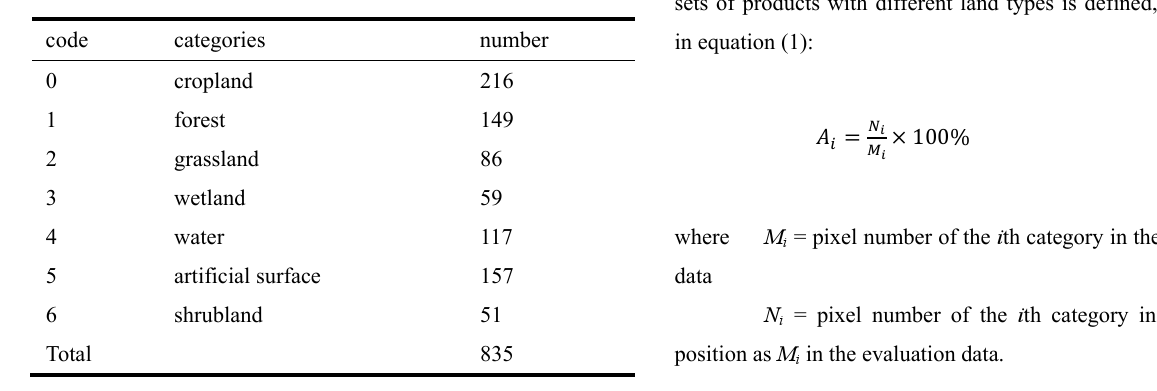
Figure 1. The distribution map of sample points in 2010 Table 1. The statistics of sample